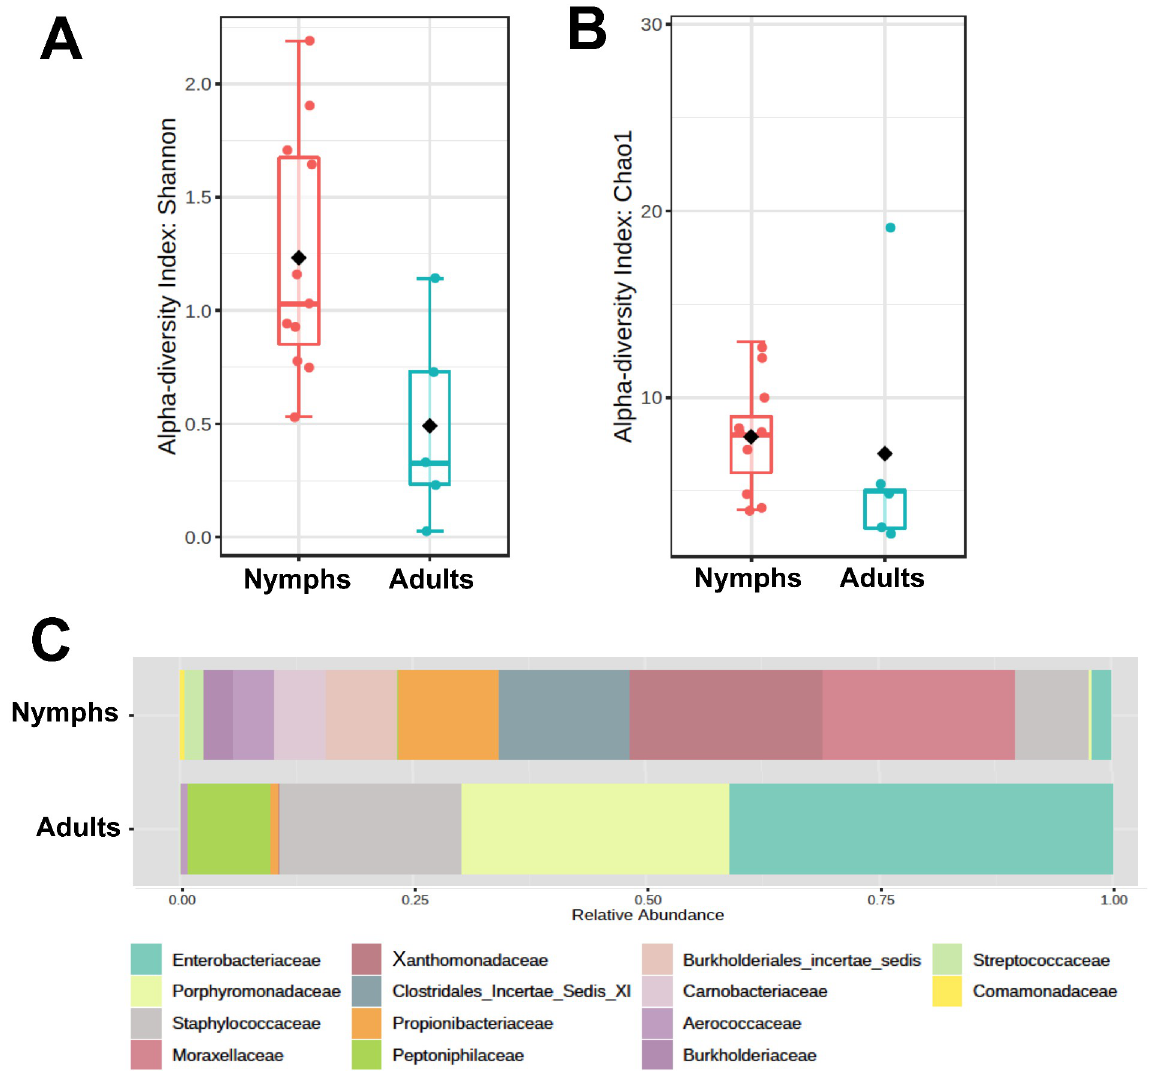
Fig 1. Diversity of T . sanguisuga microbiota during development. Box plots and individual values of alpha diversity expressed as Shannon ( A ) and Chao1 indices ( B ) were compared for laboratory-raised nymphs and field-caught adults. Nymphs presented a significantly higher Shannon index compared to adults (t = 2.88, P = 0.017), but the difference in Chao1 index did not reach statistical significance (t = 0.29, P = 0.78). ( C ) Bacterial composition of laboratory-raised nymph and field-caught adult microbiota. Taxonomic groups are color-coded as indicated.